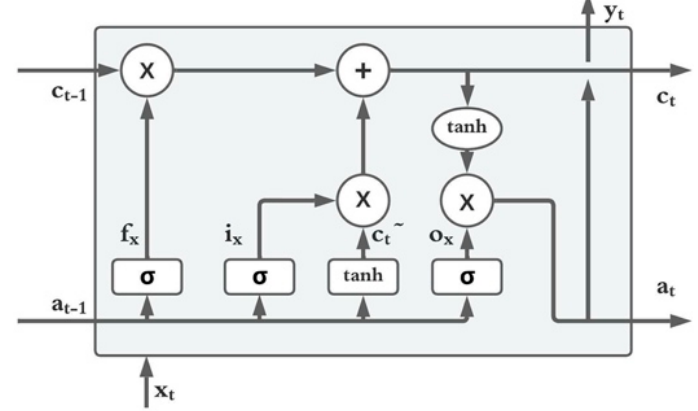
Figure 5. Structure of a LSTM unit.